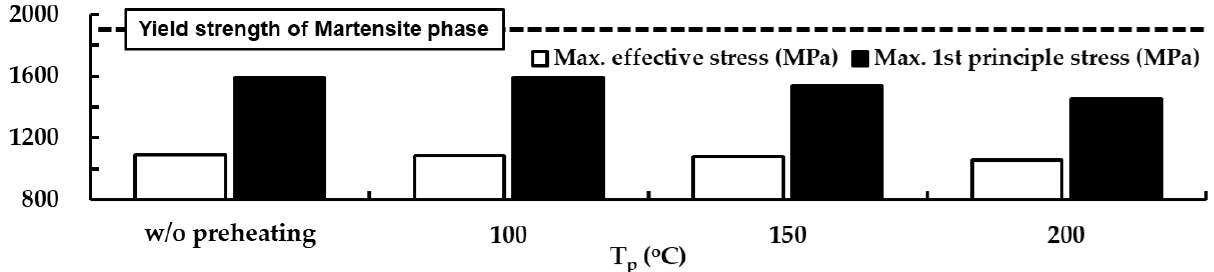
Figure 16. Influence of the preheating temperature on maximum effective and first principle stress after completion of cooling.